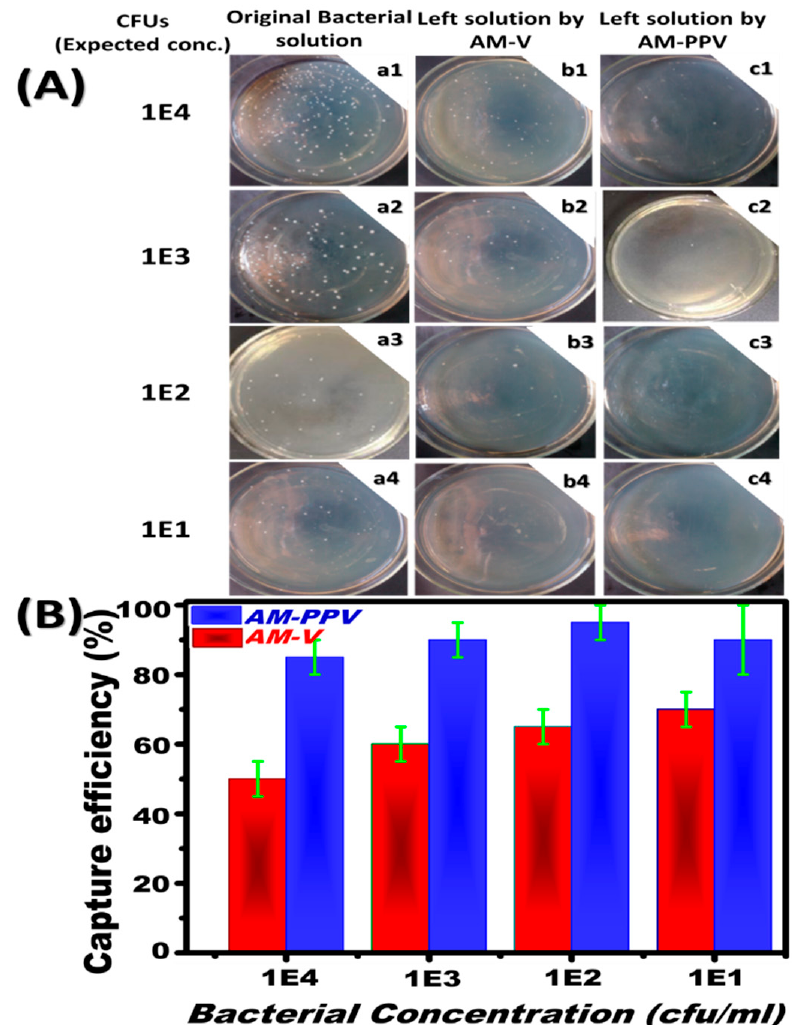
Figure 5. Comparison of the capture capabilities of amino magnetic Fe 3 O 4 /VCM NSs (AM-VCM) and furry AM-PPV NS evaluation by classical culture methods: ( A ) the photos of the plate culture presenting the colony numbers of original bacterial concentrations ranging from 1 × 10 4 to 10 CFU/mL (a1–a4); the photos of the bacteria remaining after the conjugation and magnetic separa- tion removals for AM-VCM NSs (b1–b4) and AM-PPV NSs (c1–c4) with B. cereus , respectively; and ( B ) the statistical results. Data are mean ± standard deviation (N = 3 for all